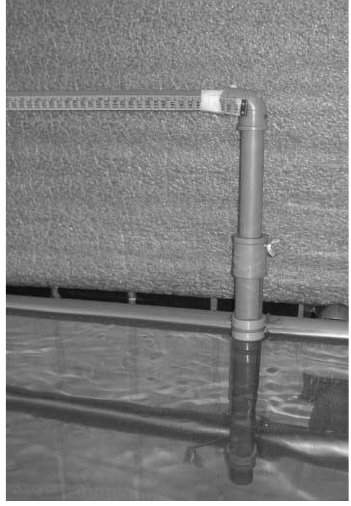
Figure 1 - Measurement equipment.